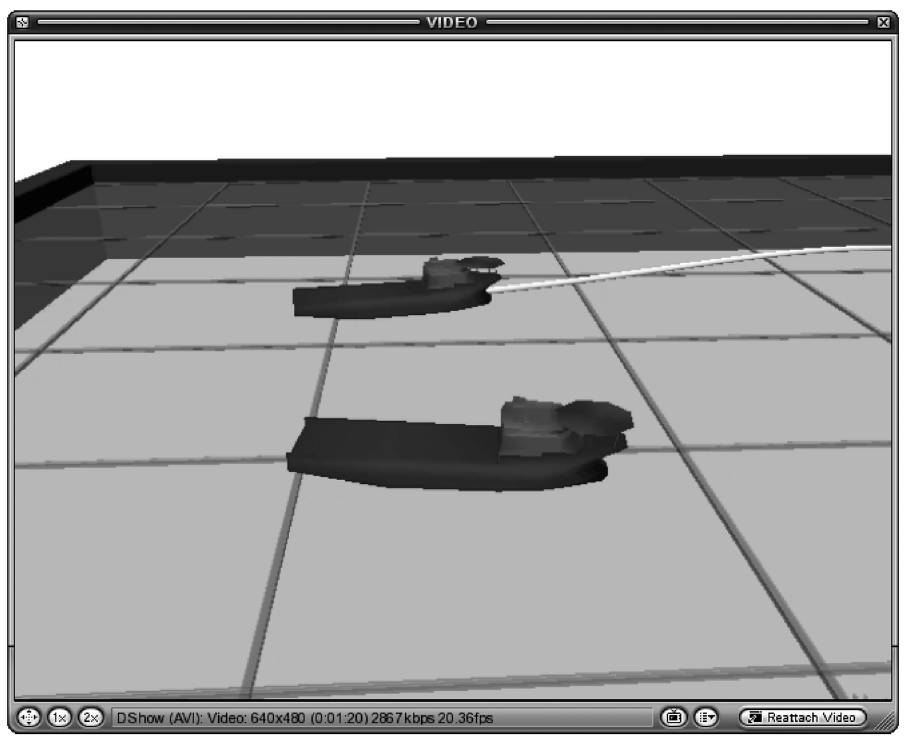
Figure 6. Snapshot of an MVT animation based on experiments of a scale vessel on a replenishment